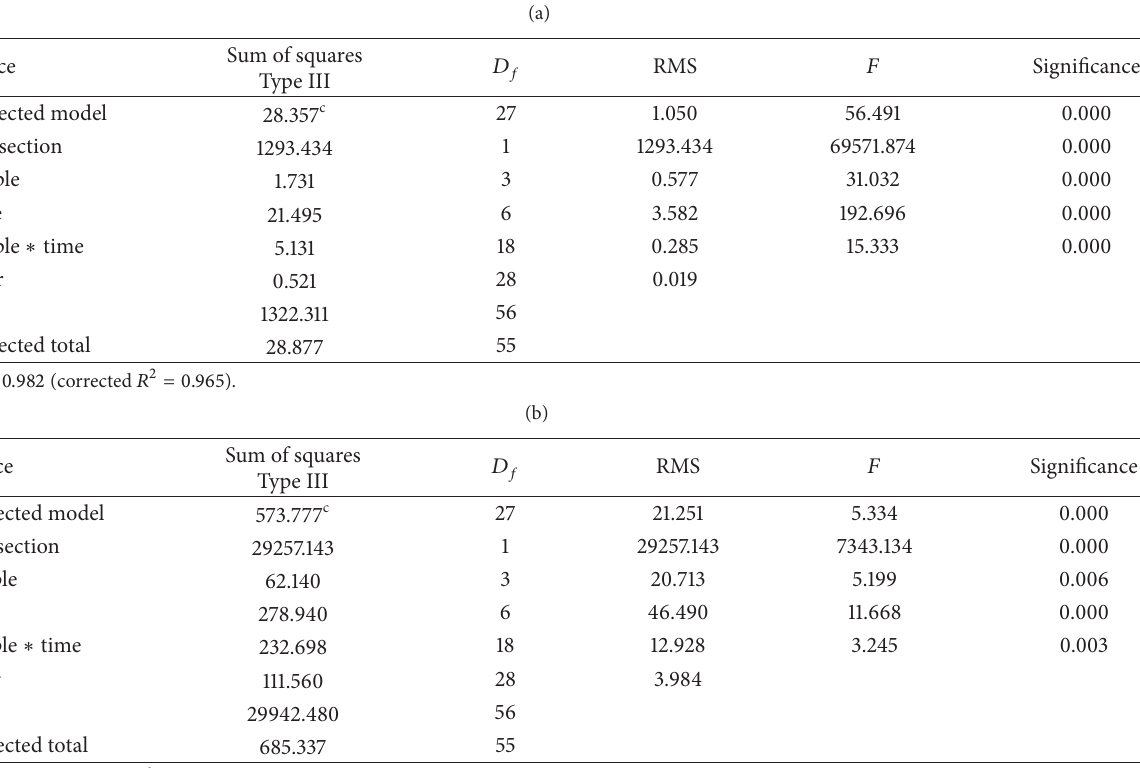
Table 4: (a) Intersubject effects proof for peroxyacetic acid for the factorial ANOVA analysis. (b) Intersubject effects proof for hydrogen peroxide HP for the factorial ANOVA